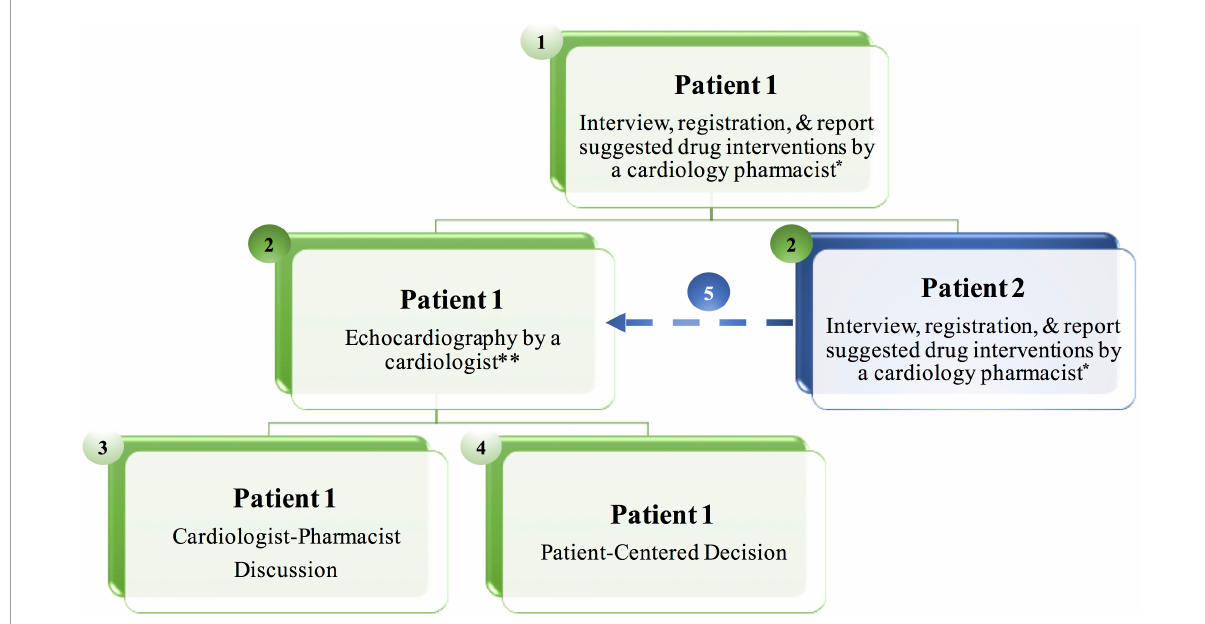
FIGURE1 The Iraqi Cardio-Oncology Program-Pharmacist (ICOP-Pharm) paradigm at the cardio-oncology clinic. The workflow consists of five steps. During Step 2 the cardiologist performs echocardiography on the first patient, at the same time, the cardiology pharmacist meets the second patient for the same action in Step 1, resulting in less patient waiting time. ∗ If a patient presents only for baseline echocardiography and has no cardiovascular risk factors or disease, the cardiology pharmacist performs a face-to-face interview and registration without drug interventions. ∗∗ When the cardiologist completes echocardiography, he informs the cardiology pharmacist about the cardiac condition, so the cardiology pharmacist adds any additional suggestions for drug interventions while the cardiologist is printing the echocardiography report before moving to Step